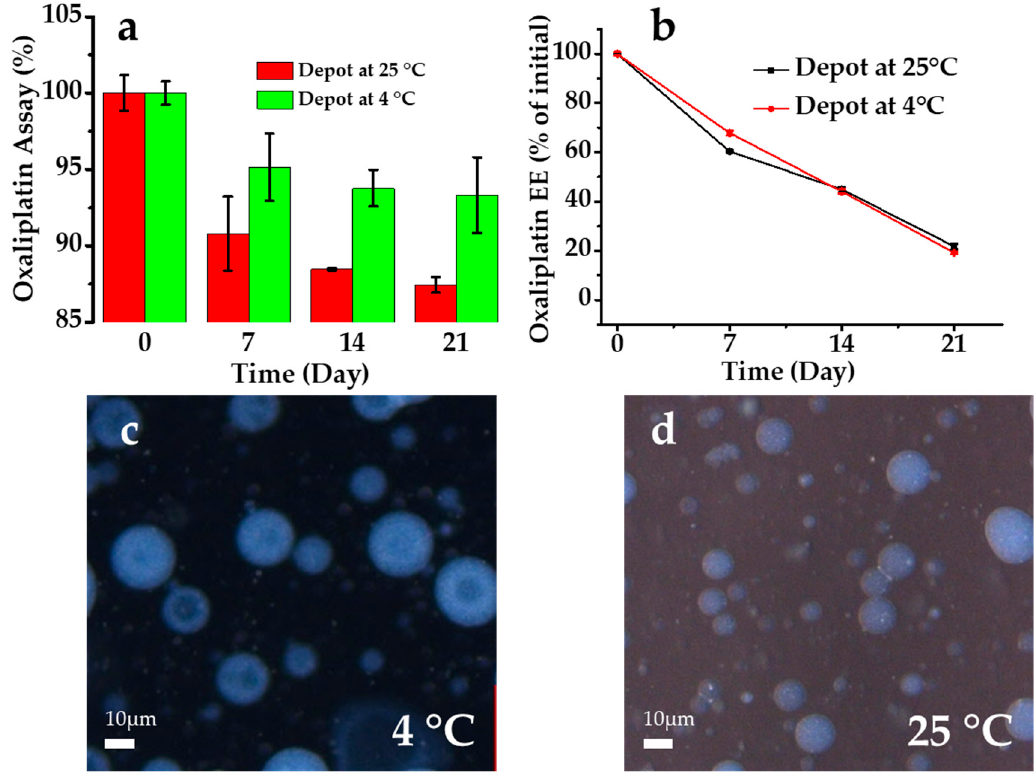
Figure 7. Study of the assay ( a ) and EE (% of initial) ( b ) of oxaliplatin at different time intervals over 3 weeks (stored at 25 °C and 4 °C). Data are expressed as the mean ± standard deviation ( n = 3). Optical microscopic image presenting the morphology of the MVL depots after 3 weeks of incubation at 4 °C ( c ) and 25 °C ( d ).